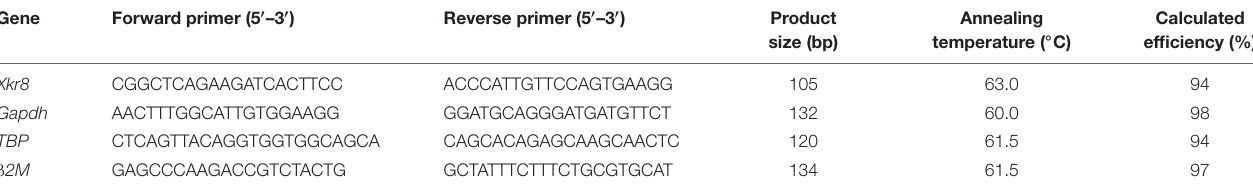
TABLE 1 | qPCR primer sequences, product sizes, annealing temperatures and calculated efficiencies for Xkr8 and three housekeeping genes. Gene Forward primer (5 (cid:48) –3 (cid:48) ) Reverse primer (5 (cid:48) –3 (cid:48) ) Product